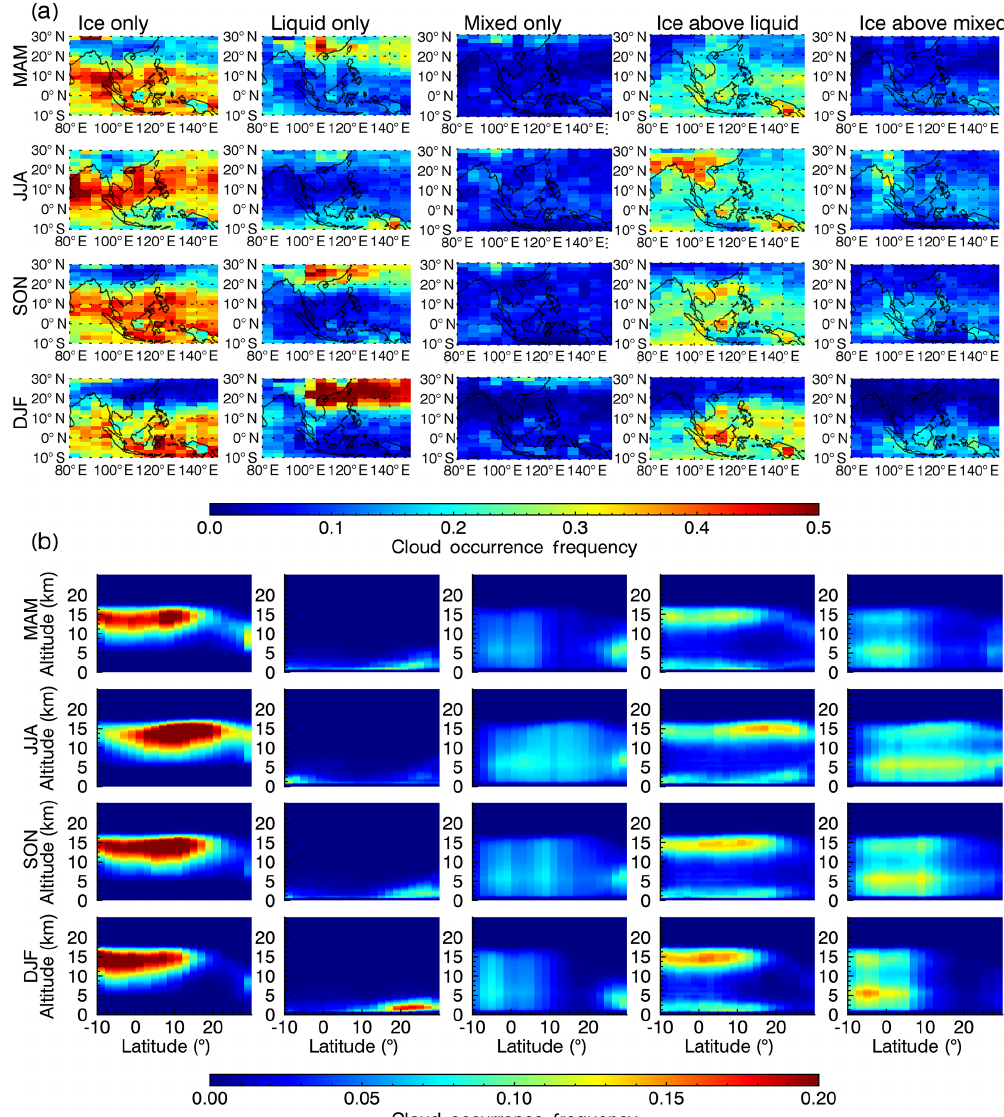
Figure 4. Occurrence frequency of the five cloud groups derived from 2B-CLDCLASS-LIDAR; (a) for horizonal distribution and (b) for zonal latitude–altitude cross